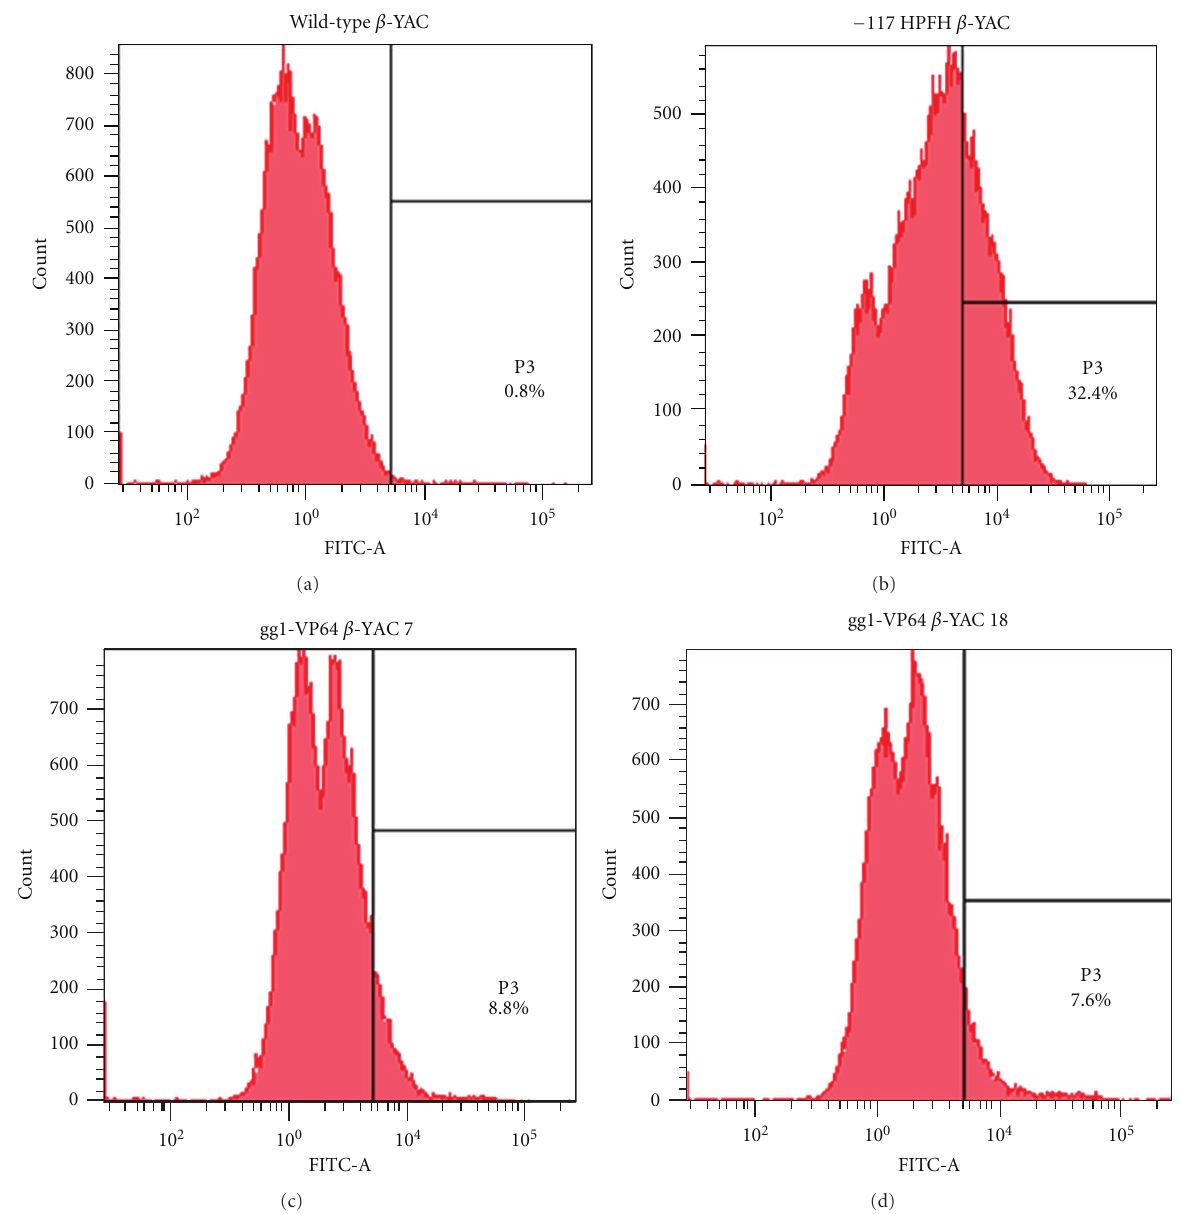
Figure 3: Flow cytometry analysis of F cells in blood from two adult gg1-VP64 β -YAC bigenic mice. A sheep anti-human hemoglobin F-FITC-conjugated antibody was used to determine the percentage of HbF-expressing cells. (a) wild-type β -YAC; (b) − 117 Greek HPFH β -YAC; (c) gg1-VP64 β -YAC 7; (d) gg1-VP64 β -YAC